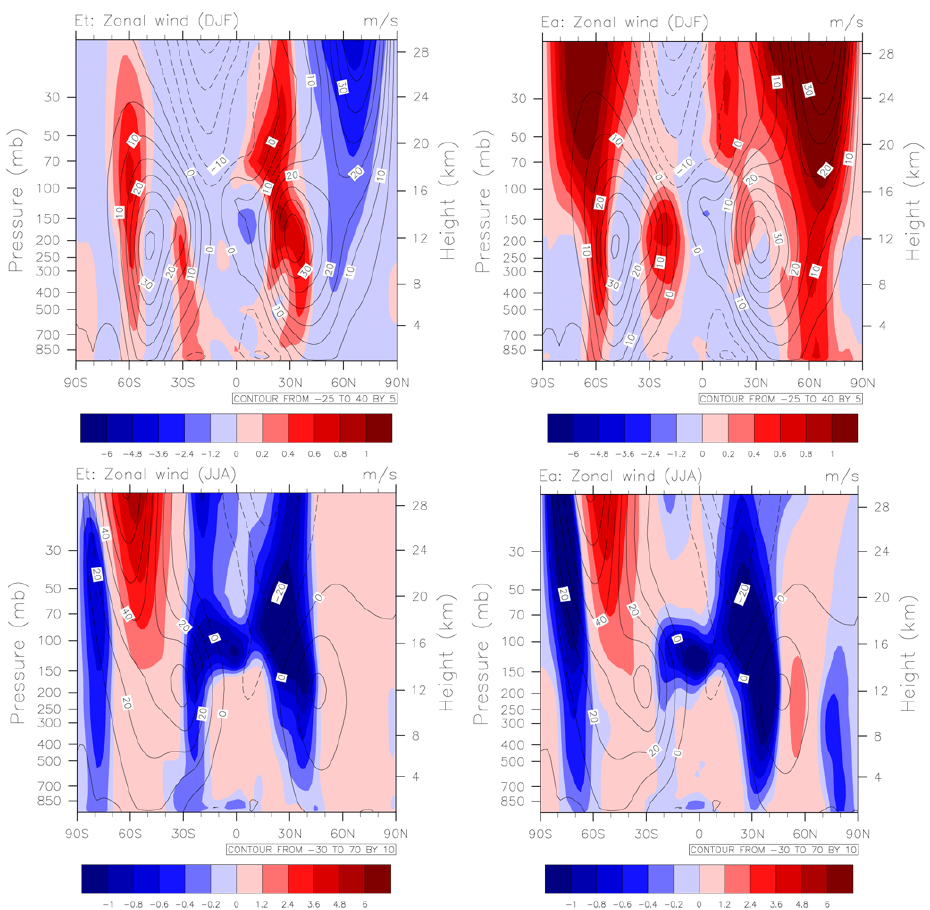
Fig. 10. Changes in zonal wind shown in color bars. The climatology is shown in contours for the no-carbon run. Unit is ms −